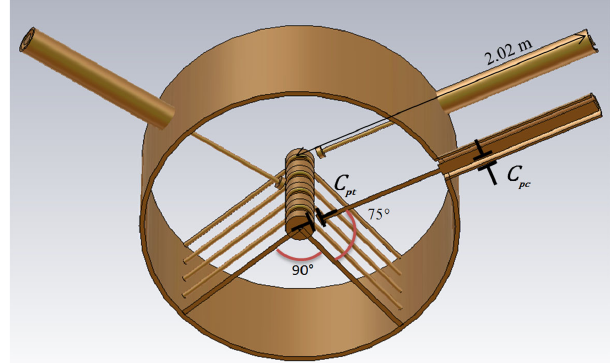
FIG. 12. Integration of post couplers with coaxial lines ex- tending out of the two-stem cavity with constant